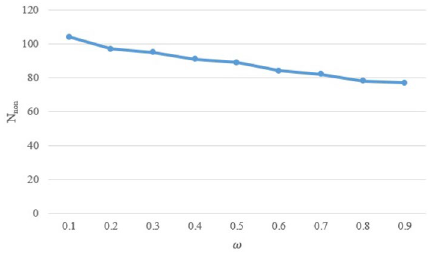
Figure 7. The effective of load-balance tolerance ( ω ) on N non .